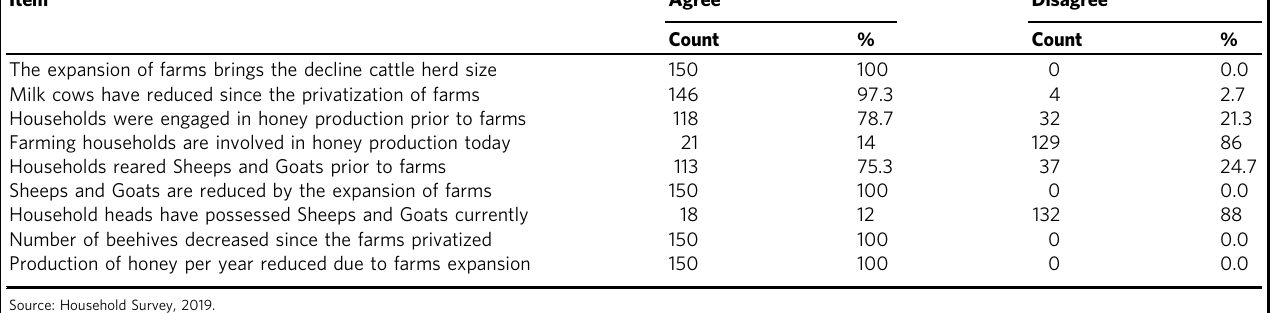
Table 2 The perception of respondents on the impacts of Birr and Ayehu farms on livestock production. Item